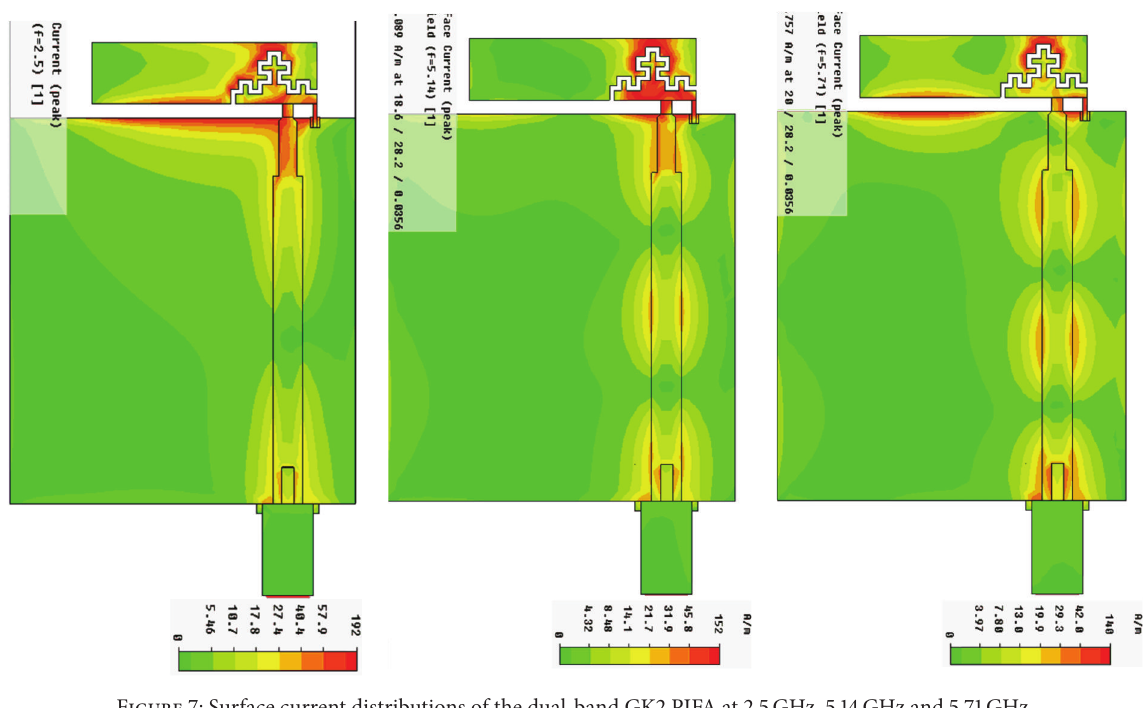
Figure 7: Surface current distributions of the dual-band GK2 PIFA at 2.5 GHz, 5.14GHz and 5.71 GHz.